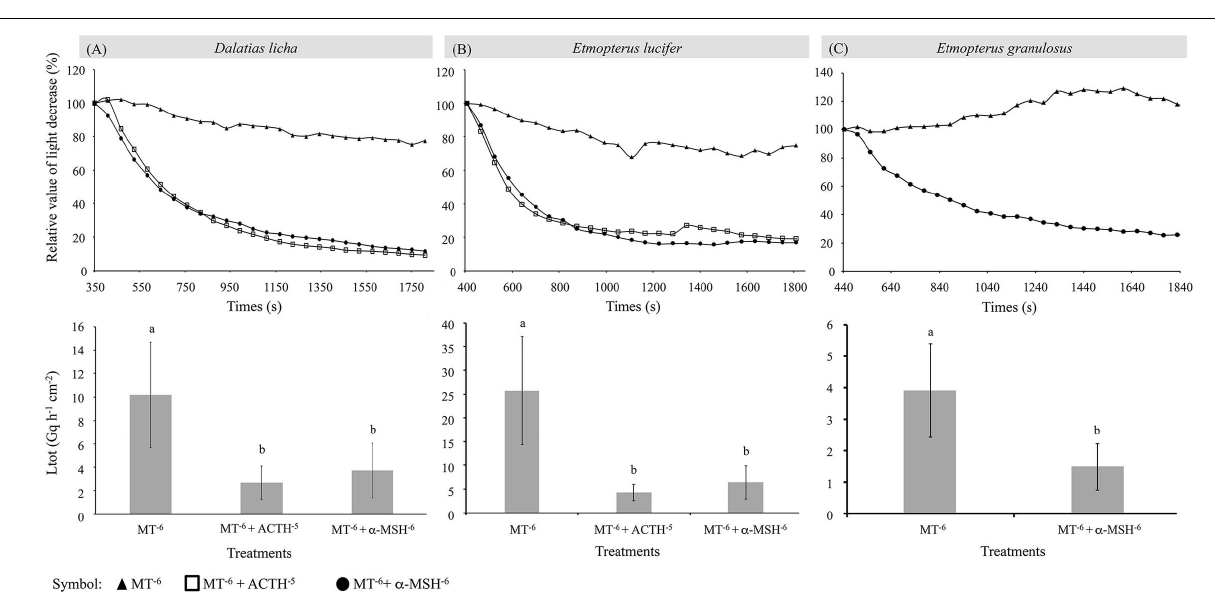
control ( Figures 6A,B and Supplementary Tables 3B, 5 ). Mean values of Lmax, TLmax, Ltot, Ltot app are presented